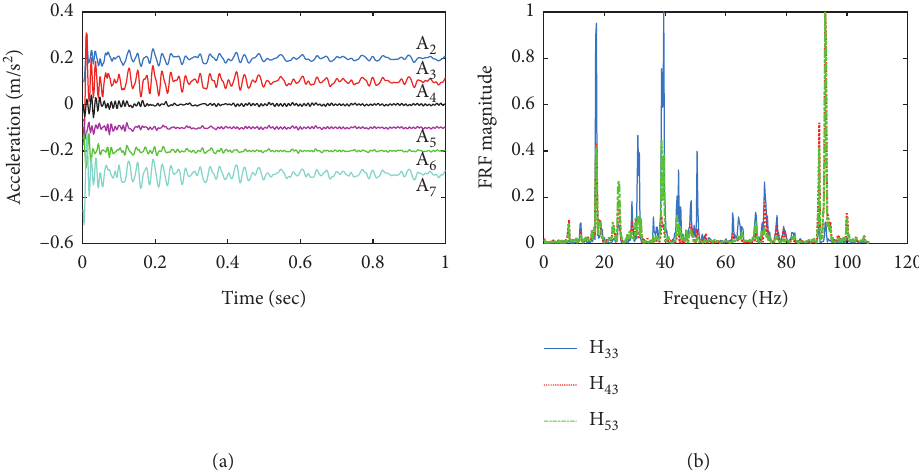
Figure 9: (a) Acceleration measurements after impact at A3 location on the column. (b) FRF of the measured accelerations (undamaged state).